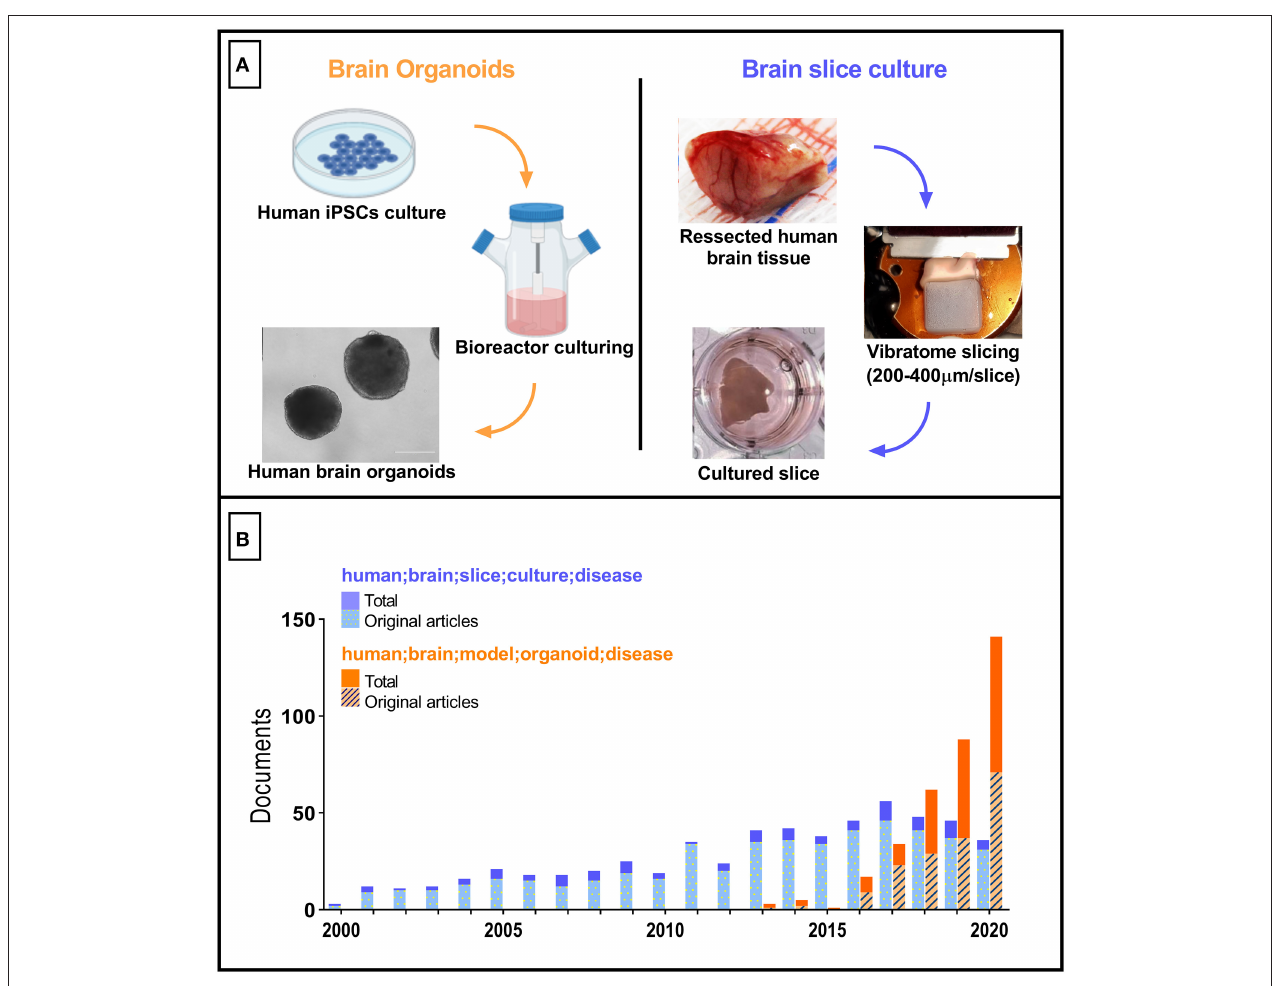
FIGURE 1 | Tridimensional human brain-derived models comparative. (A) Summarized schematics of human brain organoids (Created with BioRender.com) and slice cultures preparation processes. (B) Number of research articles per year between 2000 and 2020. Blue bars correspond to the documents retrieved with “ human; brain; slice; culture; disease ” as search terms. The total number of documents was 591 (first document retrieved published in 1987). Orange bars correspond to the documents retrieved with “ human; brain; model; organoid; disease ” as search terms. Total number of documents equals 359 (one excluded due to retraction). The Scopus database was